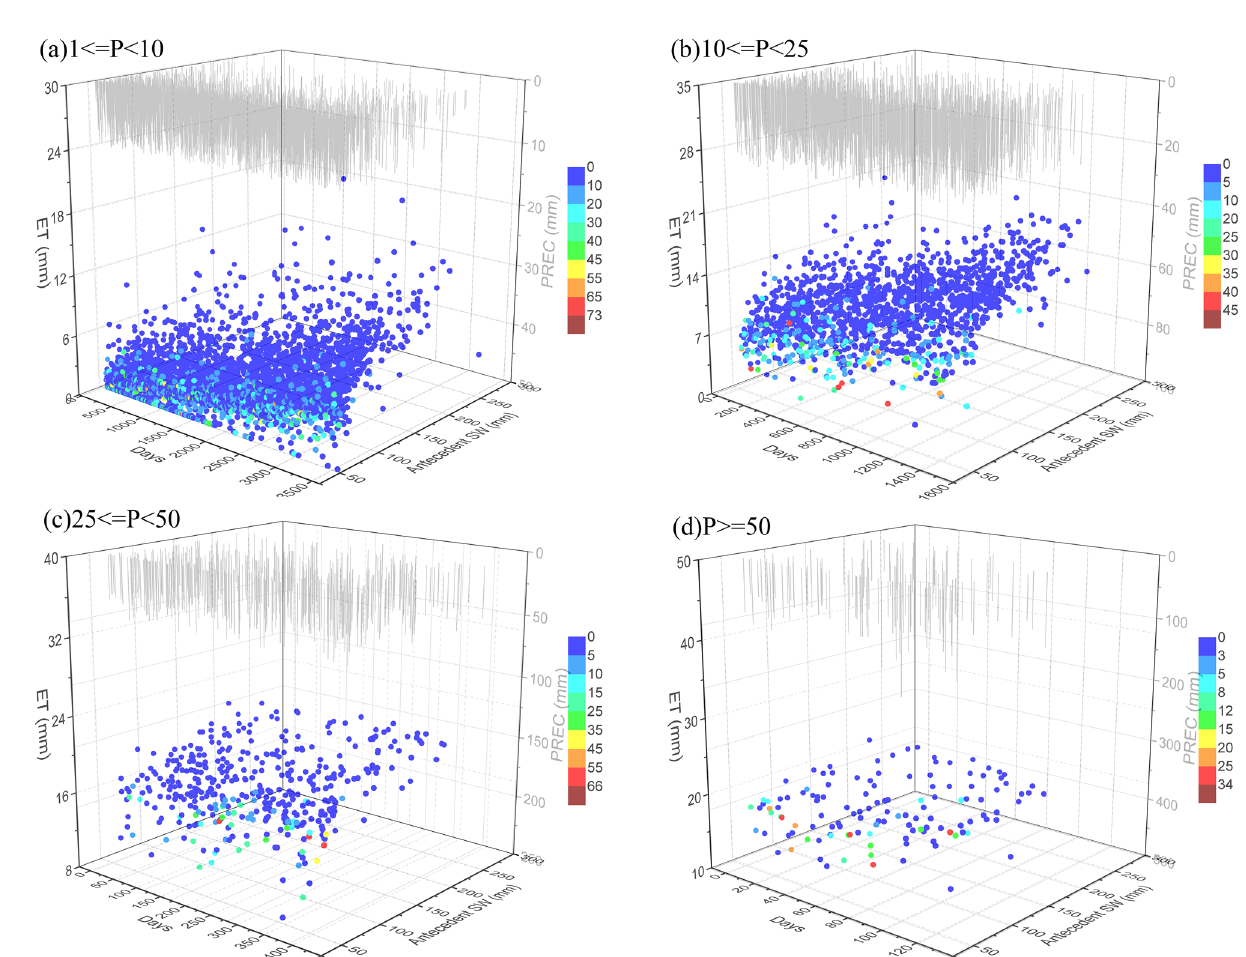
Figure 7. Relationship of ET with precipitation (PREC, mm), antecedent drought days, and antecedent soil water (antecedent SW, mm) at different precipitation amounts: ( a ) light rain (1 ≤ P < 10 mm), ( b ) moderate rain (10 ≤ P < 25 mm), ( c ) heavy rain (25 ≤ P < 50 mm), and ( d ) rainstorm (P ≥ 50 mm). Graphs were created using OriginPro software version 9.0 (https:// www. origi nlab.